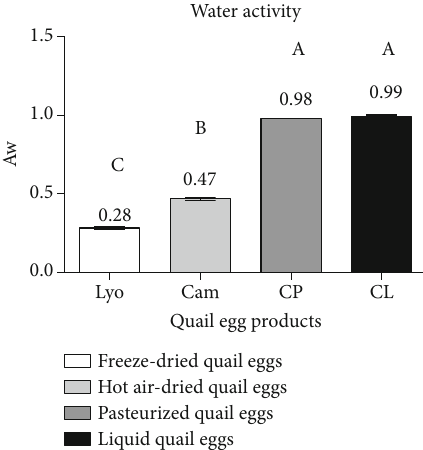
Figure 2: Water activity (Aw) of liquid (CL), freeze-dried (Lyo), hot air-dried (Cam), and pasteurized (CP) quail